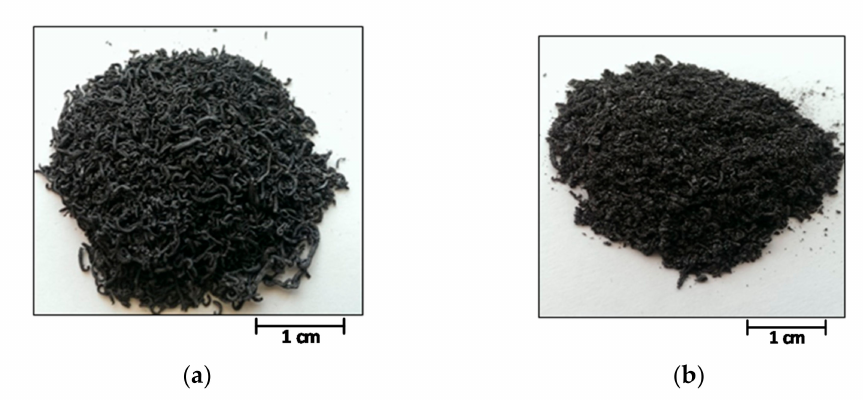
Figure 1. Appearance of the TEG1-400 ( a ) and TEG2-400 ( b )